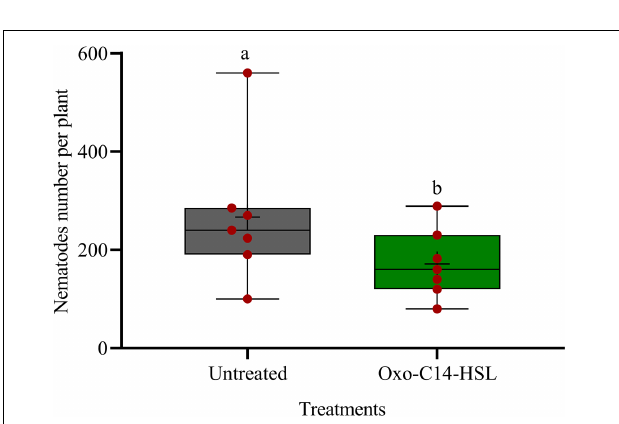
FIGURE 2 | Effect of synthetic oxo-C14-HSL as priming agent on Pratylenchus penetrans invasion into soybean roots. Different letters indicate significant differences among treatments (GLM, Poisson distribution and log link, Tukey adjustment, n = 7).